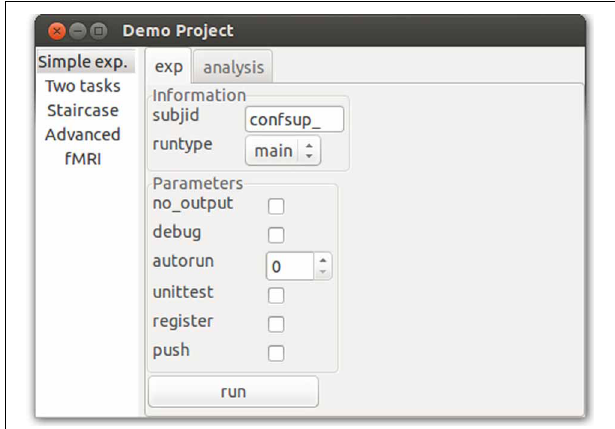
FIGURE 4 | Graphical user interface (GUI). Psychopy_ext converts info and rp parameters found in the class definition of an experiment or an analysis into GUI widgets, and methods into buttons. Note that this GUI is completely automatically generated from a class definition and does not require user